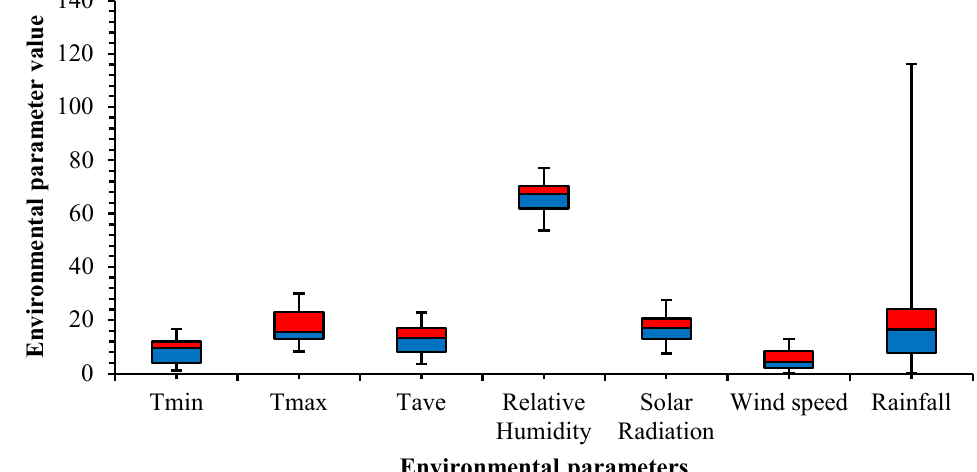
Figure A1. Box plot correlations of environmental parameters at Molise region over the study period from 1 January 2019 to 31 December 2021. (Note: Tmin, Tmax, and Tave = minimum, maximum, and average temperatures ( ◦ C); relative humidity at 9:00 to 21:00 (local time) (%); solar radiation (MJ m 2 month − 1 ); wind speed (m s − 1 ); and rainfall (mm)).